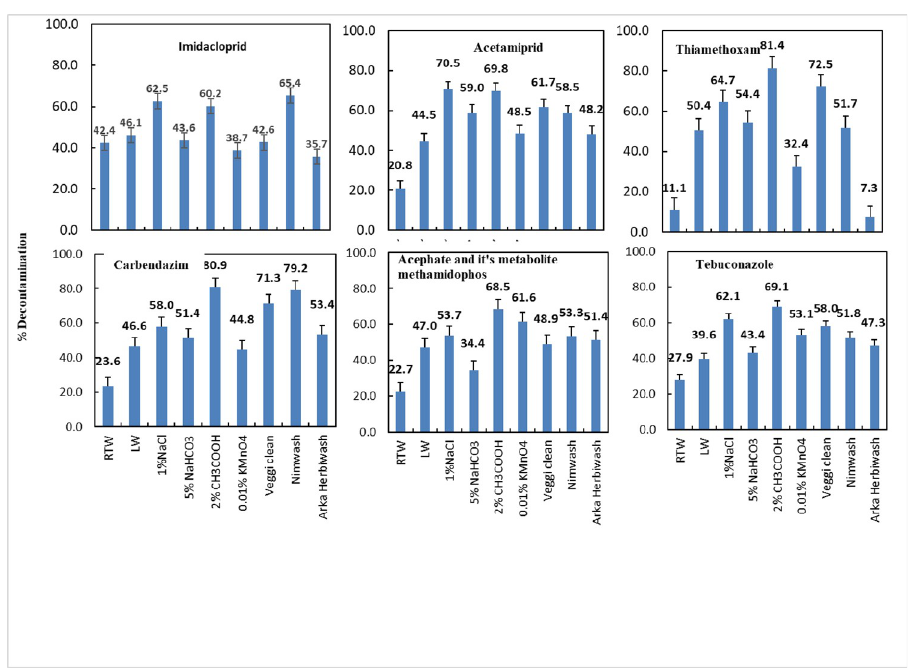
Fig 1. Effect of different decontamination treatments on % removal of pesticides analyzed by HPLC-UV on okra. The vertical bars indicate critical difference at P � 0. The numerical values against histograms indicate percent (%) decontamination of pesticide